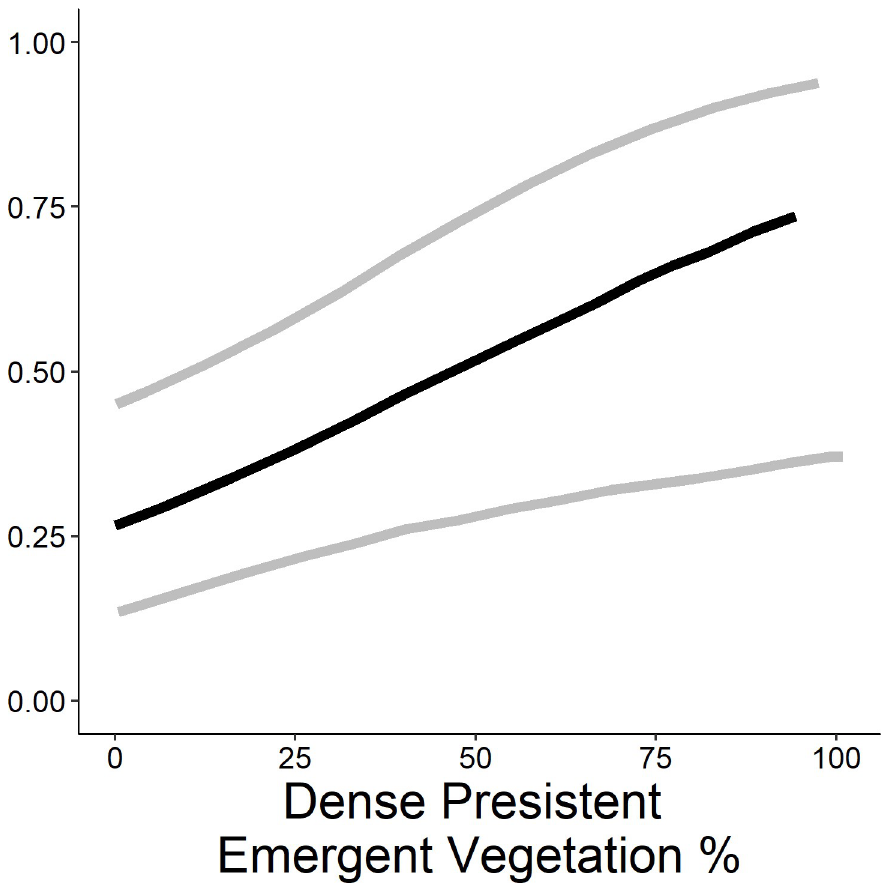
Fig 8. Predicted probability (95% confidence limits) of site occupancy for the emergent marsh bird group (American bittern, Botaurus lentiginosus ; least bittern, Ixobrychus exilis ; sora, Porzana Carolina ; king rail, Rallus elegans ; virginia rail Rallus limicola , and yellow rail, Coturnicops noveboracensis ) across dense persistent emergent vegetation coverage in Illinois during late spring and early summer 2015–2017.